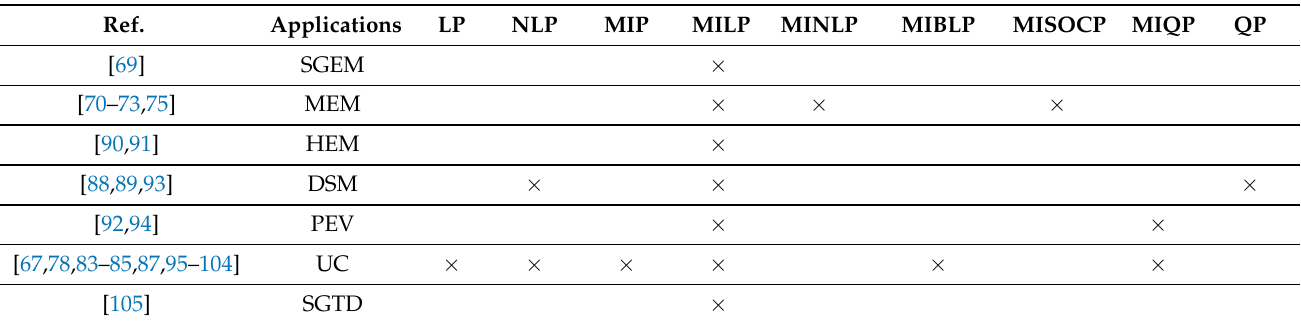
Table 3. Applications of robust optimization and its problem